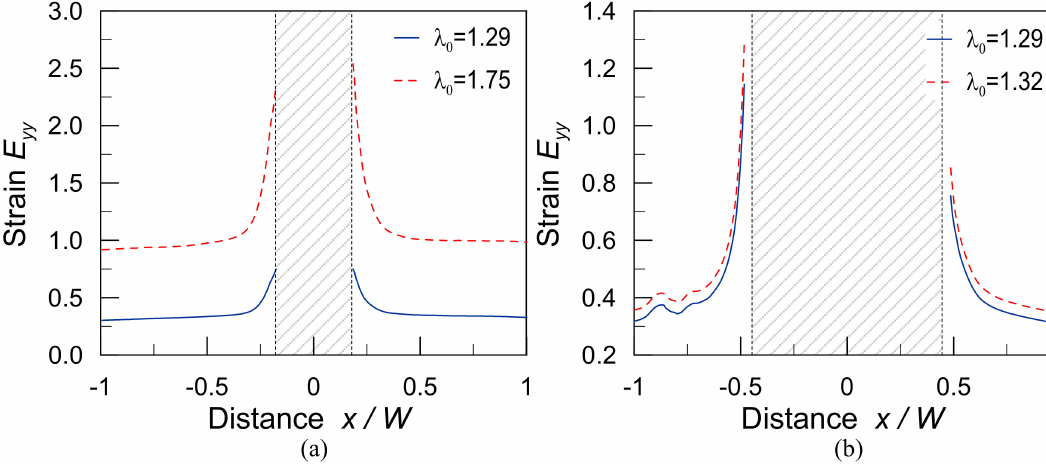
Figure 6. Green–Lagrange strain E yy distribution along the cracked section of the plate, at an intermediate (continuous lines) and ultimate values (dashed lines) of the remote applied